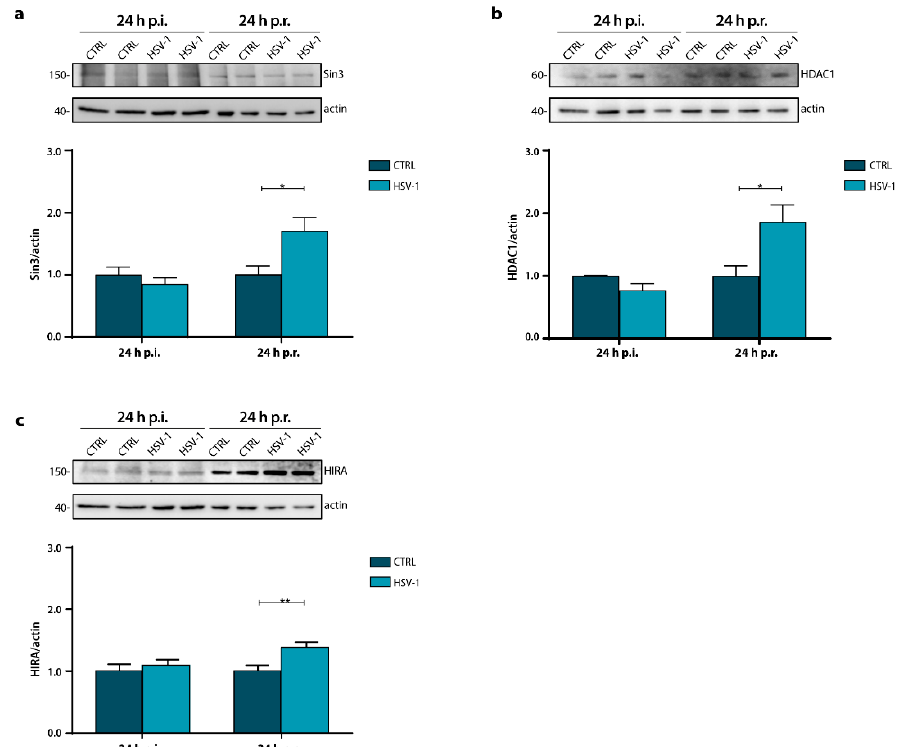
Figure 2. Sin3, HDAC1 and HIRA expression during a recurrent HSV-1 infection in vitro. Represen- tative immunoblots showing Sin3 ( a ), HDAC1 ( b ), and HIRA ( c ) protein levels in lysates from Mock- and HSV-1-infected neuronal cultures harvested 24 h p.i. or 24 h p.r. Actin staining was used as a loading control. Densitometric analyses were performed with ImageLab software and normalized to actin expression. The values represent the normalized fold-changes in protein levels from 24 h p.r. CTRL or HSV-1 samples with respect to 24 h p.i. CTRL. Data are mean ± SEM of three independent experiments. * p < 0.05; ** p < 0.01. Statistical significance was calculated by Mann–Whitney test.